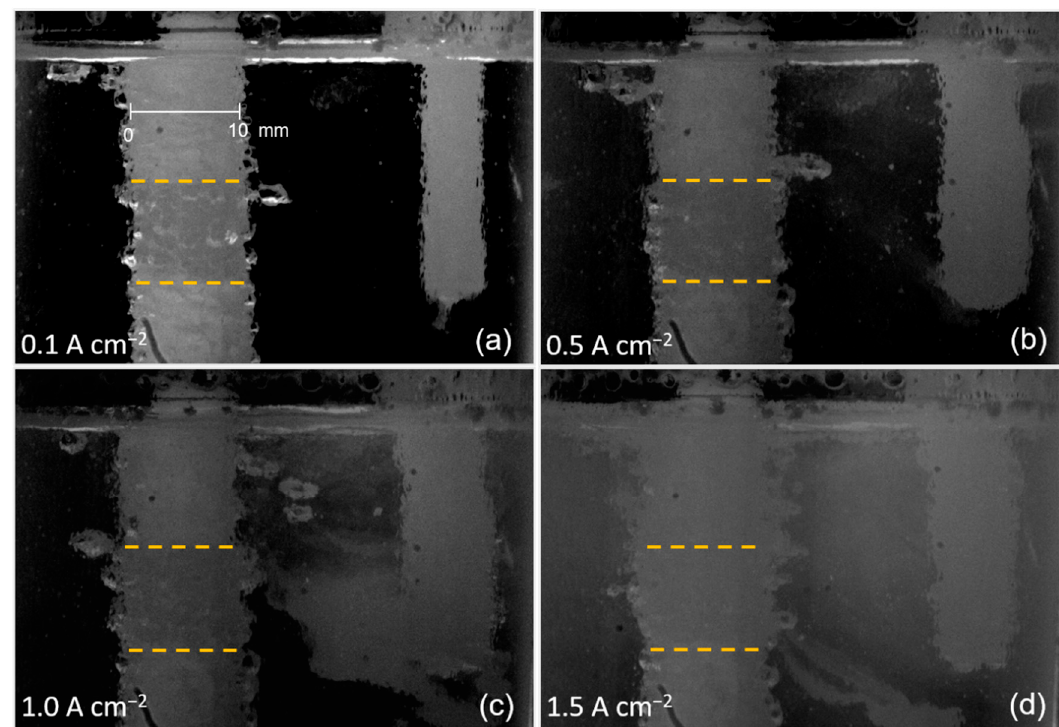
Figure 18. Images of bubble evolution at the vertical anode during electrolysis at different current densities: ( a ) 0.1, ( b ) 0.5, ( c ) 1.0, and ( d ) 1.5 A cm − 2 . The yellow line indicates the border between the carbon and boron nitride material. The frame rate was 125 fps. A scale bar is shown in ( a ).